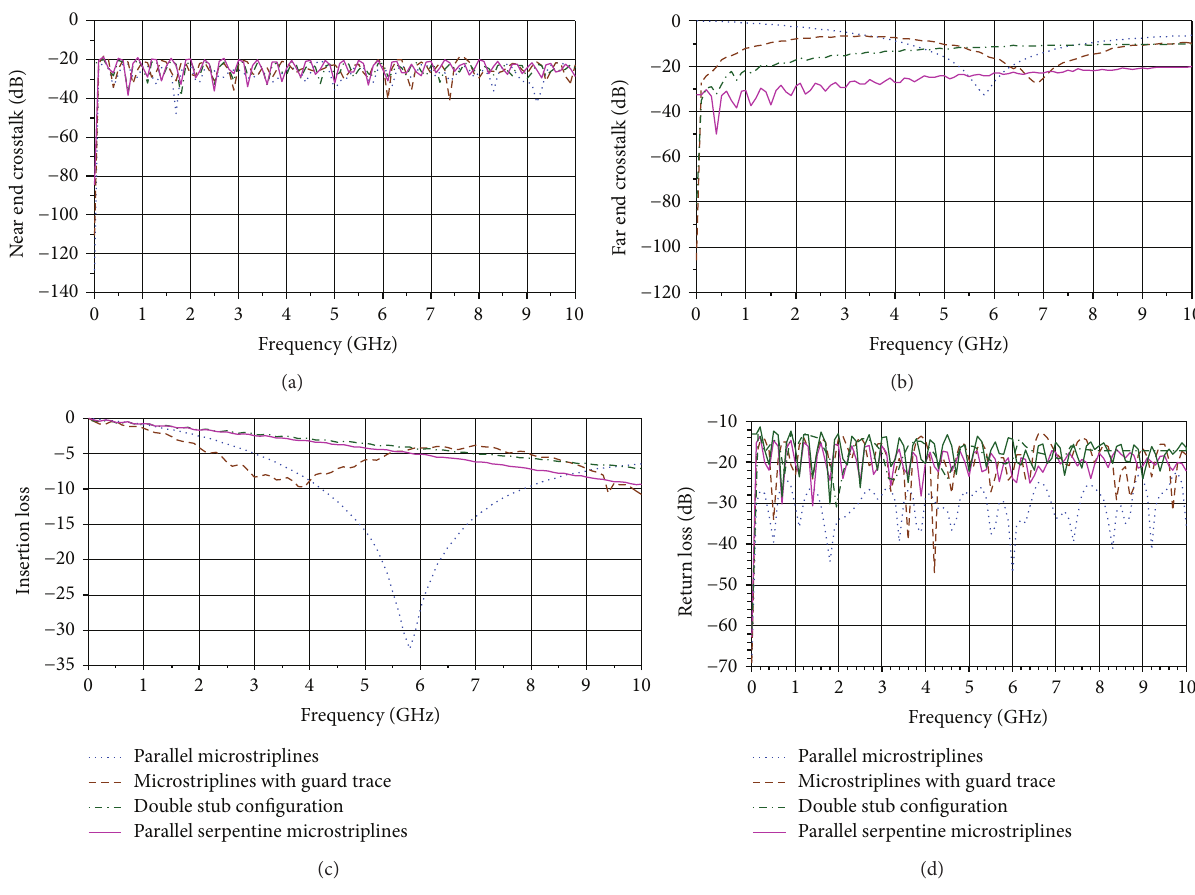
Figure 10: Measured results for various microstripline structures for the (a) NEXT and (b) FEXT. (c) Insertion loss; (d) return loss.